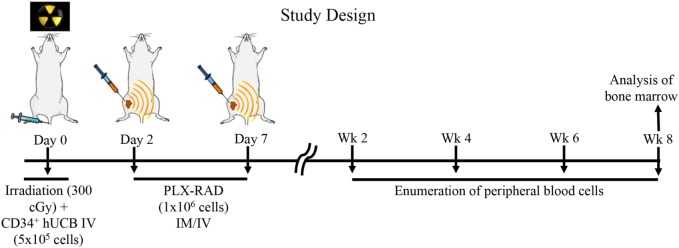
Study design: NSG mice received 300 cGy total body irradiation prior to receiving 5 × 105 CD34+ selected cells from human umbilical cord blood (UCB). Following non-lethal irradiation (300 cGy), two groups of NSG mice were studied: (1) intravenous (IV) 5 × 105 UCB CD34+ cells and (2) IV 5 × 105 UBC CD34+ cells and 1 × 106 intramuscular (IM) PLacental eXpanded (PLX)-R18 on D2 and D7. Peripheral blood from transplant recipient mice were analyzed on weeks 2, 4, 6, and 8. Bone marrow from transplant recipient mice was analyzed on week 8.